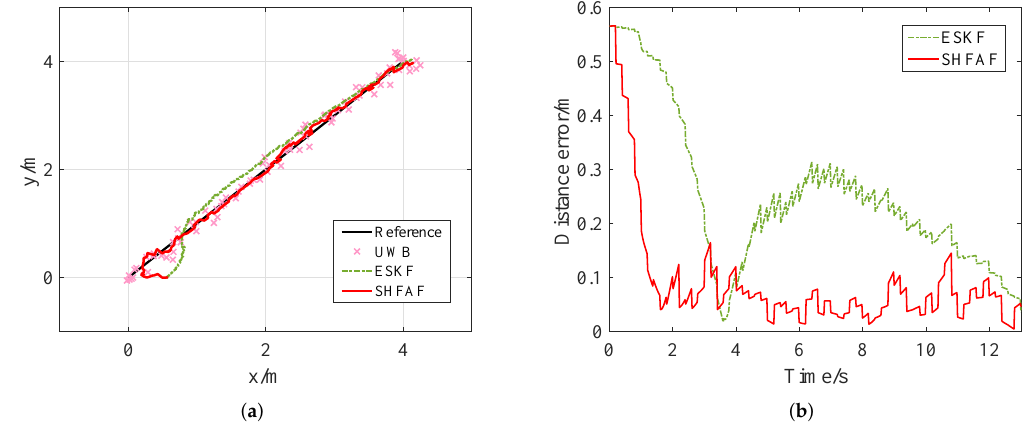
Figure 7. The simulation results in Scenario 1. ( a ) The estimated position trajectory in which outliers are not considered, but time-varying noise and initial error are set up. ( b ) The absolute distance error of positioning